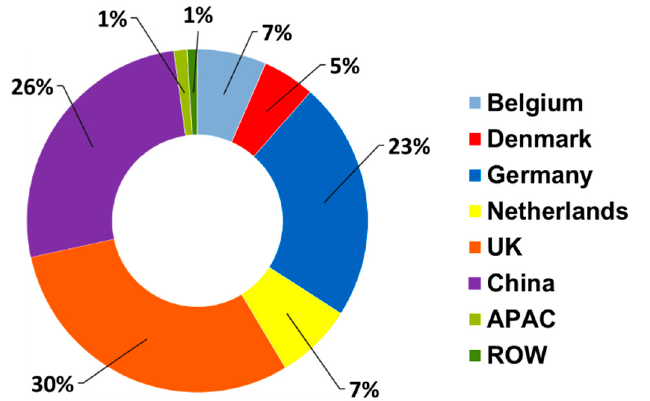
Figure 1. Distribution of offshore installations by country in 2020 (Where ROW means rest of the world and it is formed by the following countries: Finland, France, Ireland, Norway, Sweden, Portugal, and Spain).